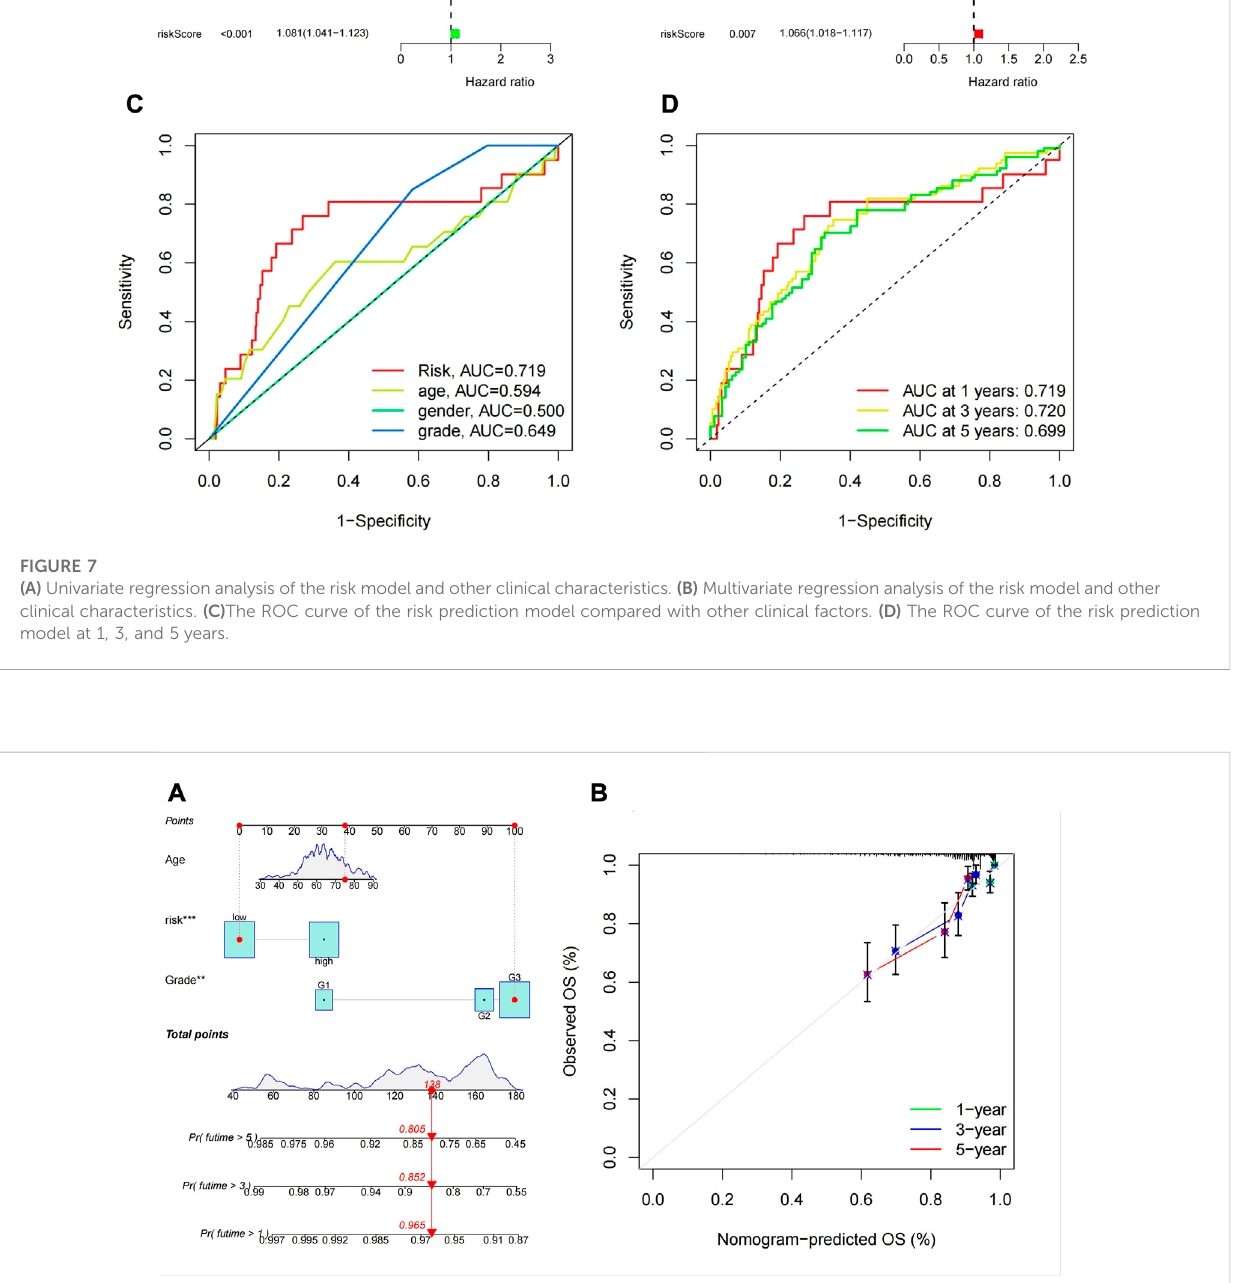
FIGURE 8 ThepredictivesignifcanceoftheCuproptosis-associatedLncRNAsignaturewasverifedinthenomogrammodel. (A) Nomogramcombiningthe fi ve Cuproptosis-associated LncRNA signatures. (B) Calibration plots of 1-, 3-, and 5-year survival